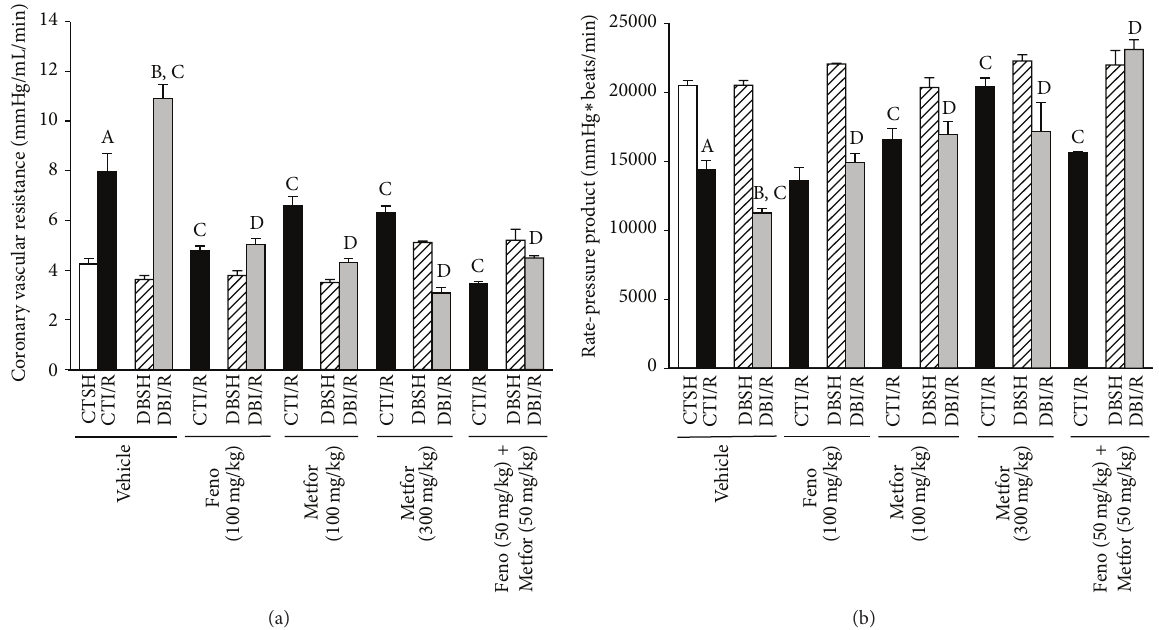
Figure 3: Evaluation of the ex vivo cardiac hemodynamics in control-ischemia/reperfusion (CTI/R) and diabetic-ischemia/reperfusion (DBI/R) conditions. (a) Coronary vascular resistance and (b) rate-pressure product were both measured ex vivo by Langendorff technique. A 𝑃 < 0.05 versus control-sham- (CTSH-) Vehicle, B 𝑃 < 0.05 versus diabetic-sham- (DBSH-) Vehicle, C 𝑃 < 0.05 versus CTI/R-Vehicle, and D 𝑃 < 0.05 versus DBI/R-Vehicle two-way ANOVA followed by Duncan’s post hoc test. Data are presented as means ± SEM of 6 animals per